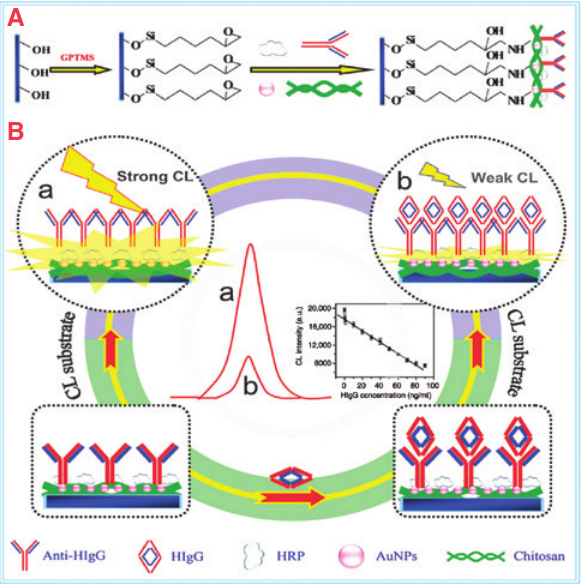
Figure 4: Schematic of the preparation method of the immunosensor and label-free chemiluminescent immunoassay of HIgG. Reprinted with permission from Ref. [157]; copyright 2015, Royal Society of